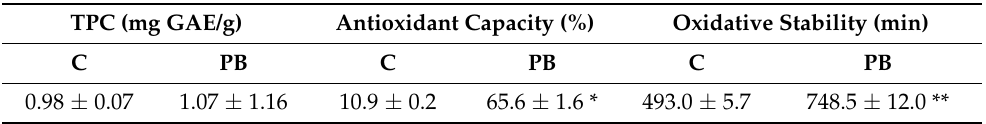
Table 3. Total phenolic content (TPC), antioxidant capacity, and oxidative stability, means and standard deviations, in control (C) and parchment bread